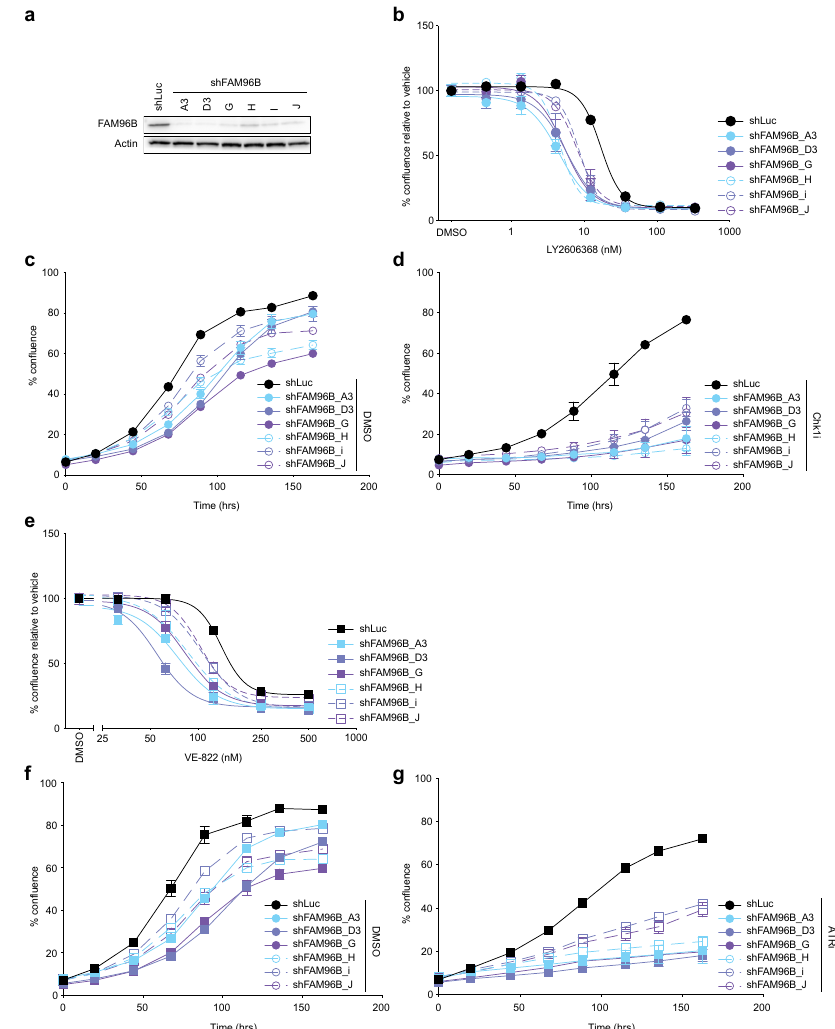
Fig. 4 Loss of CIA2B-FAM96B increases sensitivity to inhibition of the ATR/Chk1 pathway. SUM159 cells were stably transduced with a non-targeting shRNA (shLuc) or 6 different shRNAs targeting CIA2B-FAM96B. a CIA2B-FAM96B knockdown was con fi rmed by Western blotting. b Control shLuc or FAM96B-depleted SUM159 cells plated at a density of 2.5 × 10 3 cells per well in triplicate were allowed to attach overnight, and then treated for 135 h with the indicated doses of Chk1i. Cell growth was monitored by live-cell imaging; percent cell con fl uence is plotted ( y -axis) against the concentration of Chk1i used ( x -axis, LY2606368). c , d Control shLuc or FAM96B-depleted SUM159 cells were treated for 135 h with either DMSO or Chk1i (10 nM Ly2606368). Percent well con fl uence as a function of time is indicated. e Control shLuc or FAM96B- de fi cient SUM159 cells plated at a density of 2.5 × 10 3 cells per well in triplicate were allowed to attach overnight, and then treated for 135 h with the indicated doses of ATRi (VE-822). Cell growth was monitored by live-cell imaging; percent cell con fl uence relative to DMSO treated cells is plotted ( y -axis) against the concentration of ATRi used ( x -axis, VE-822). f , g Control shLuc or FAM96B-depleted SUM159 cells were treated for 135 h with either DMSO or ATRi (200 nM VE-822). Percent well con fl uence as a function of time is indicated. b – g Data point — mean; error bars — SEM of three independent